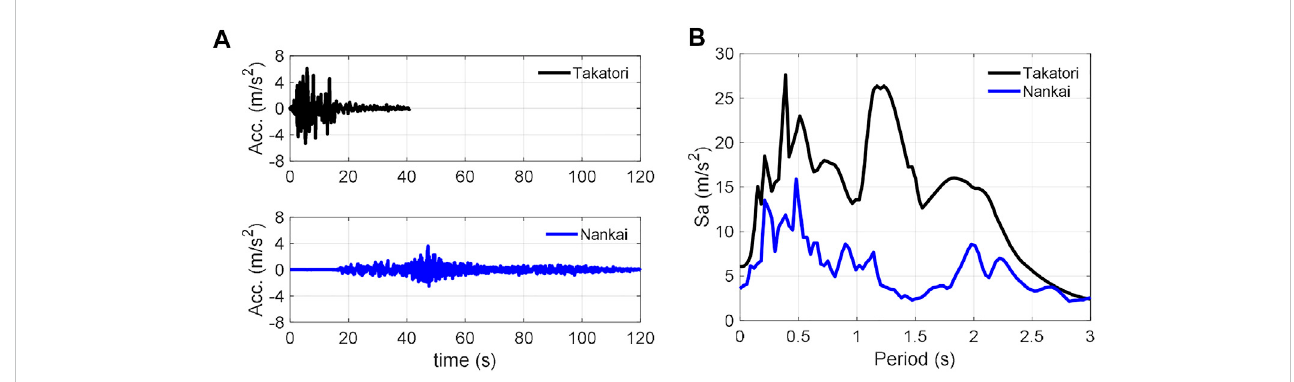
FIGURE 6 Ground motion records employed in the E-Defense experiments: (A) acceleration time history and (B) acceleration response spectra.